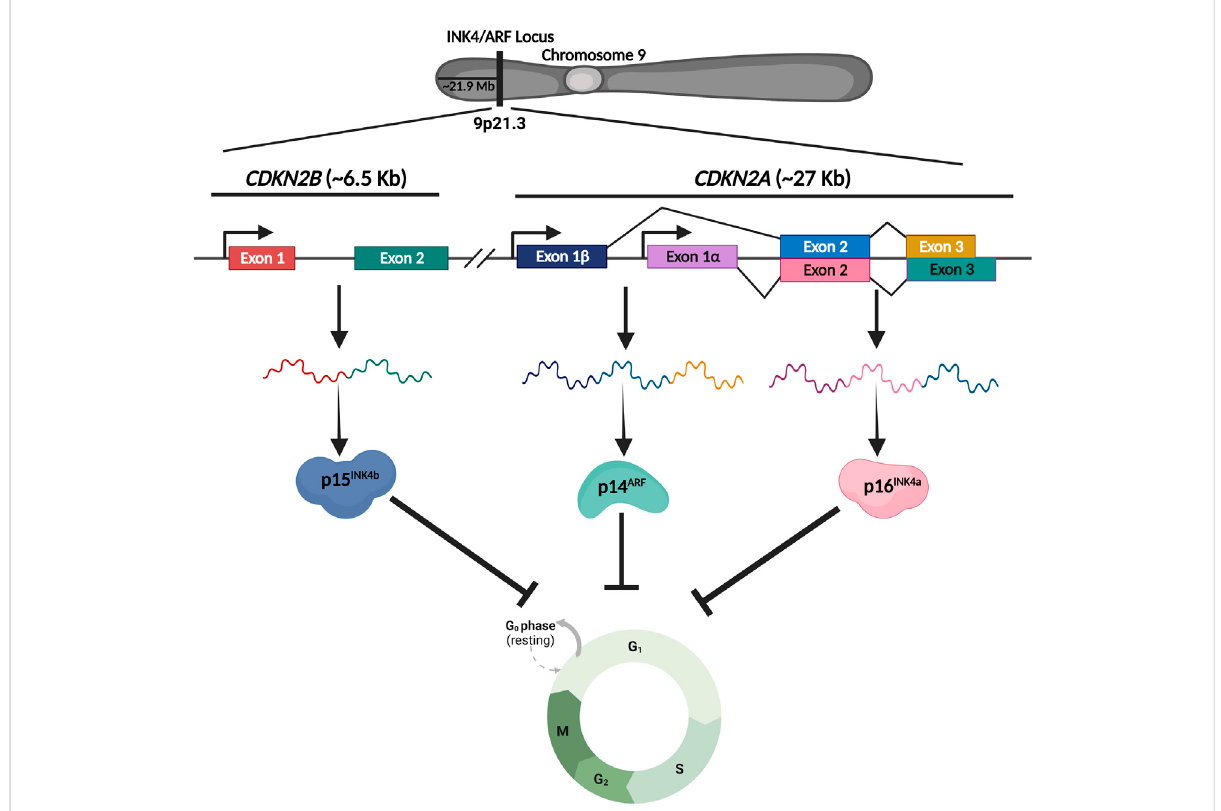
FIGURE 1 Schematic representing the genomic structure of INK4/ARF locus. INK4/ARF locus harbors two genes, CDKN2A and CDKN2B , that code for three critical cell cycle regulators. CDKN2A gene produces two proteins, p16 1NK4a and p14 ARF , whereas the CDKN2B gene produces p15 1NK4b . Together these genes regulate the cell cycle under various